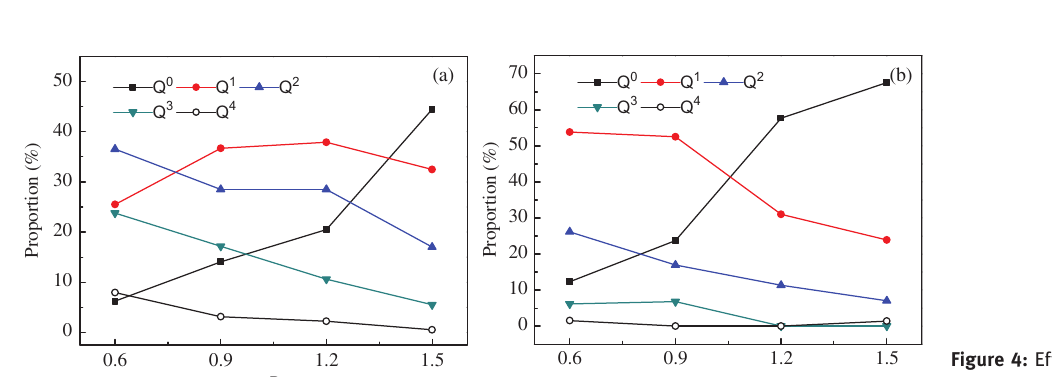
Figure 3: Proportions of differ- ent oxygen types with varying slag basicity.